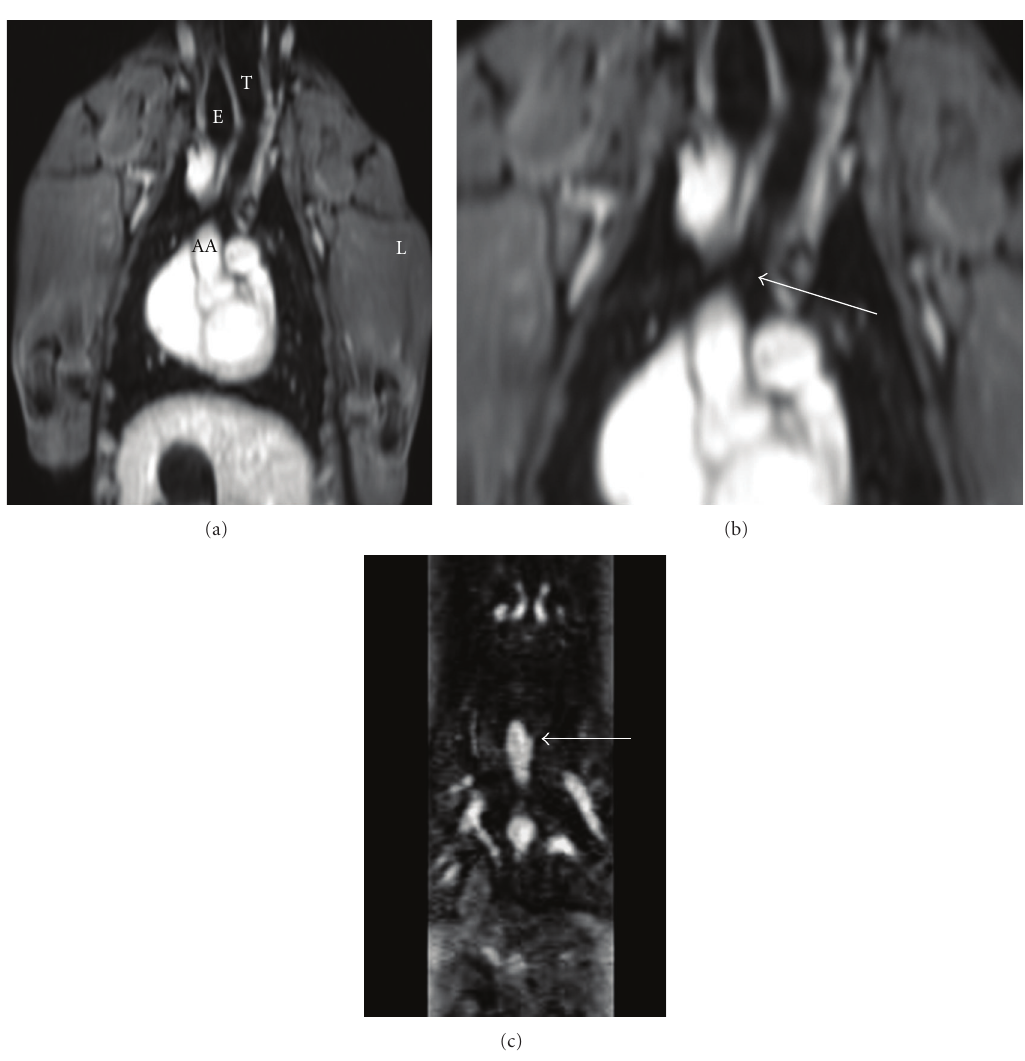
Figure 2: CE-MRA images demonstrating persistent right aortic arch with left-sided ligamentum arteriosum and focal megaesophagus. Dorsal plane image (a) shows the location of the aortic arch (AA) on the right and displacing the trachea (T) and dilated esophagus (E) to the left. An indistinct linear soft tissue band extends leftward from the proximal descending aorta immediately caudal to the area of maximum esophageal dilation ((b); arrow) consistent with the left ligamentum arteriosum. Dorsal maximum intensity projection reconstructed image at the level of the cranial descending aorta (c) demonstrates a small focal left-sided dilation of the aorta consistent with the ductus diverticulum (arrow). There is no evidence of blood flow through the ligamentum